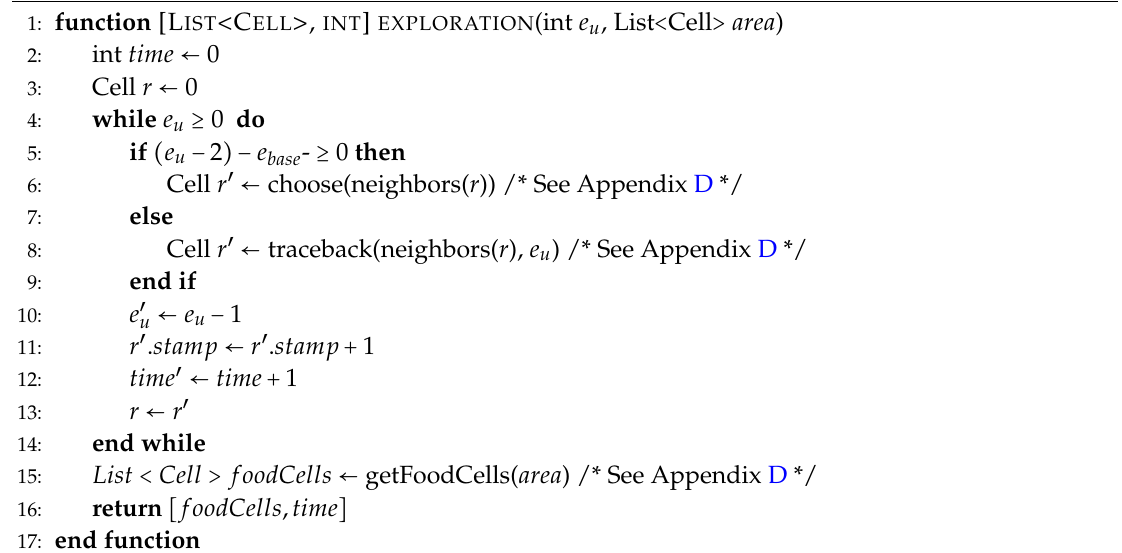
Algorithm 1 Exploration